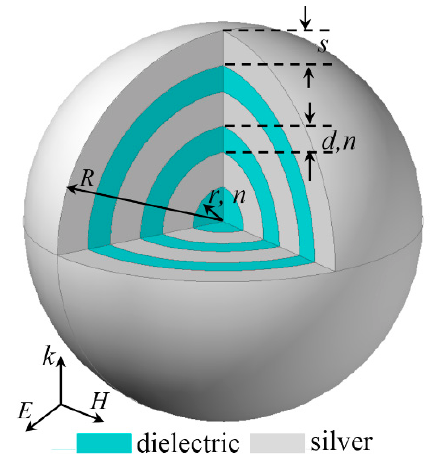
Figure 1. Schematic of a spherical HMM cavity with total radius of R , which consists of a dielectric nanosphere core (radius: r ) and 5 alternating layers of silver (thickness: s )/dielectric (thickness: d ). The refractive indexes of dielectric nanosphere core and the dielectric layers are set as the same value of n .